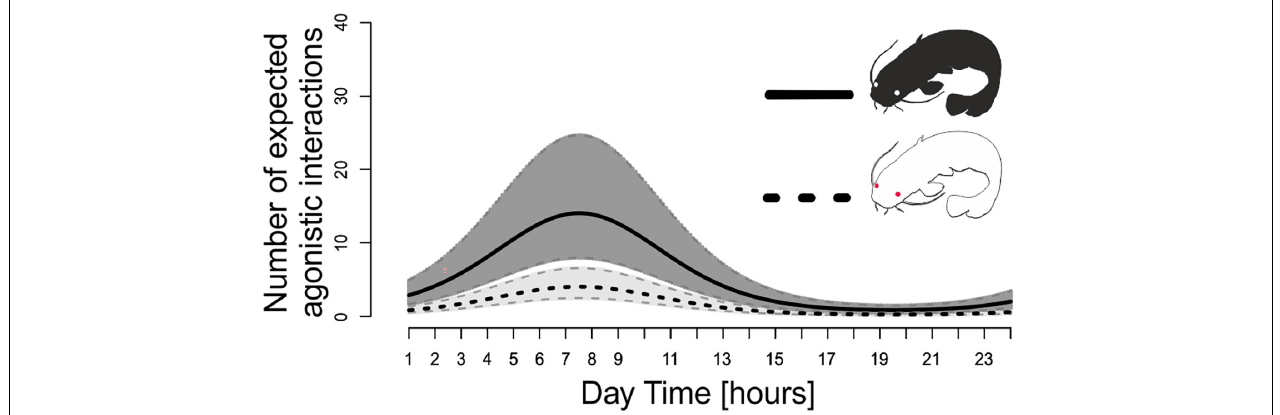
FIGURE 6 | Number of expected agonistic interactions related to sampling interval of albino (dashed black line) and pigmented (solid black line) catfish throughout the diel cycle. Predicted lines are displayed with gray 95% pointwise confidence